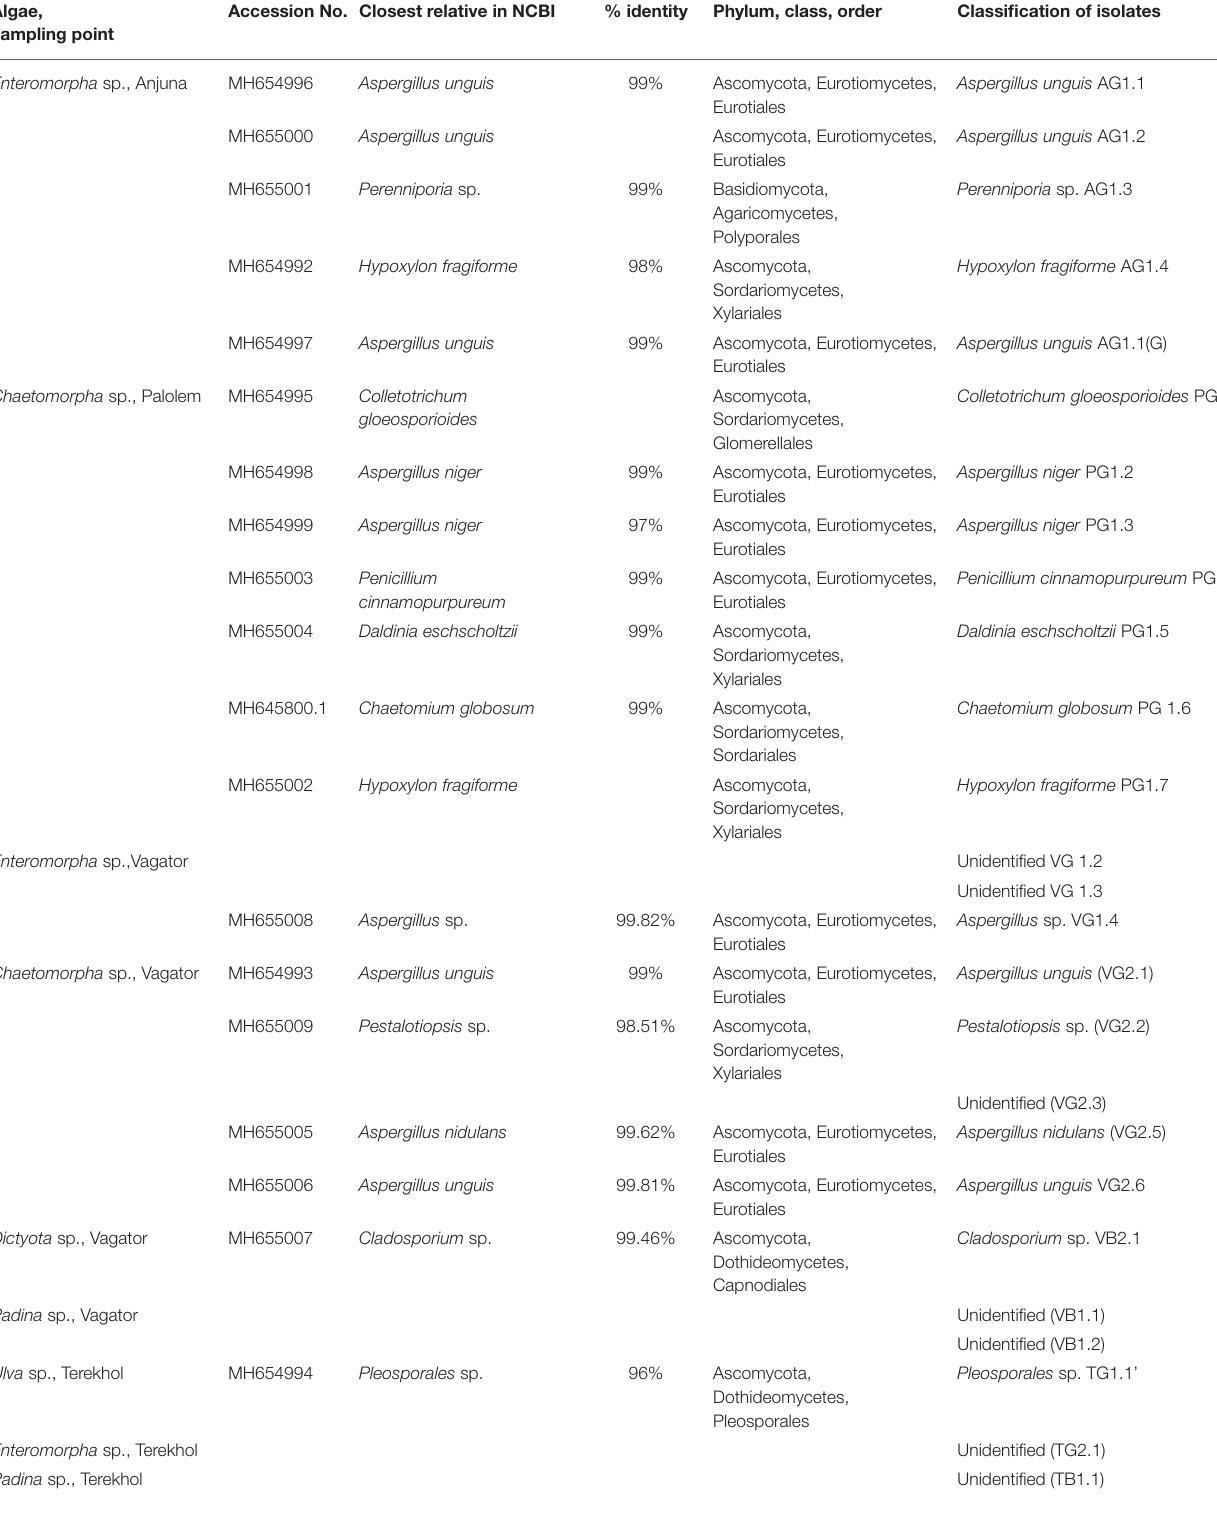
TABLE 2 | Culturable endophytic fungi identified from marine algae collected from Konkan coast, India. Algae, sampling